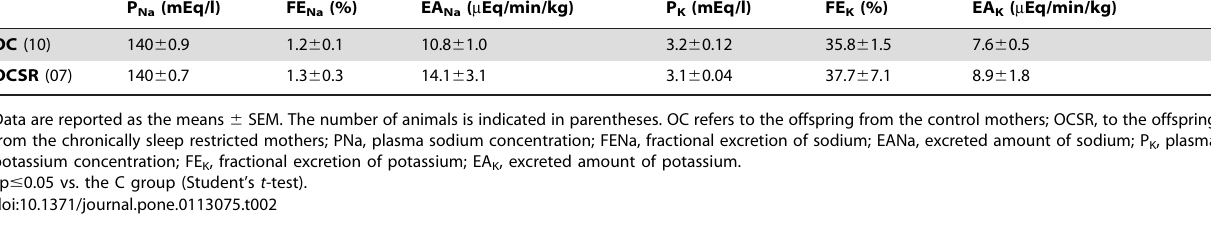
144 6 2.59 mmHg).